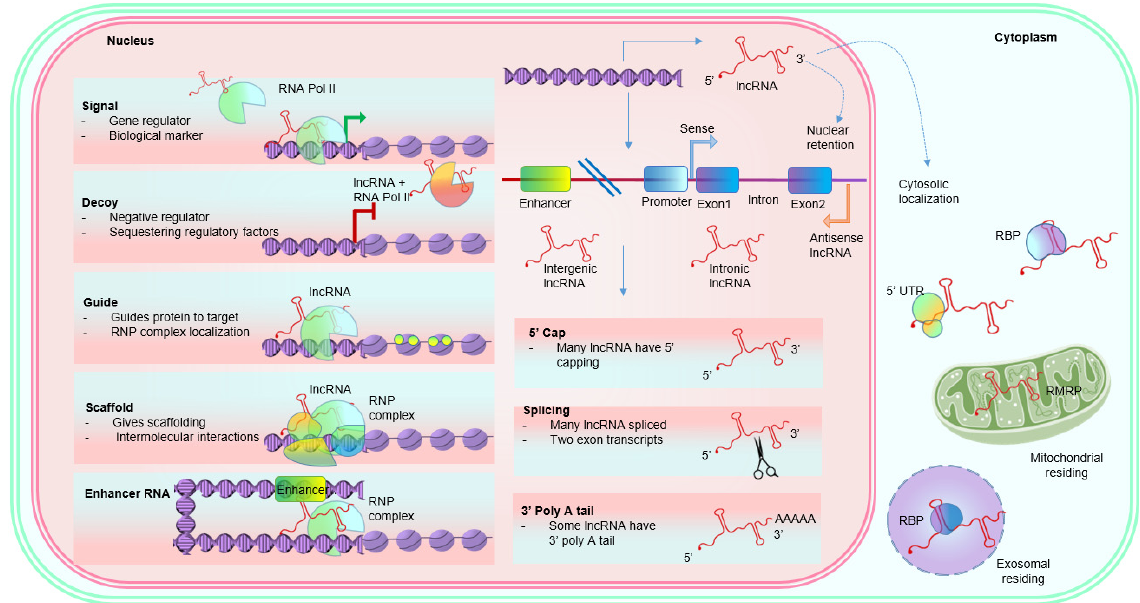
Figure 1. Archetypes and characteristics of lncRNAs along with their nuclear or cytoplasmic localizations. The various archetypes explain their mechanism of action in a non-mutually exclusive fashion. LncRNAs exhibit post-transcriptional signatures such as mRNA. Depending upon the splicing, lncRNA can either retain in the nucleus or localize in the cytosol. Abbreviations: LncRNAs, long noncoding RNAs; RNP, ribonucleoprotein; UTR, untranslated region; RMRP, RNA component of mitochondrial RNA-processing endoribonuclease; RBP, RNA-binding protein.